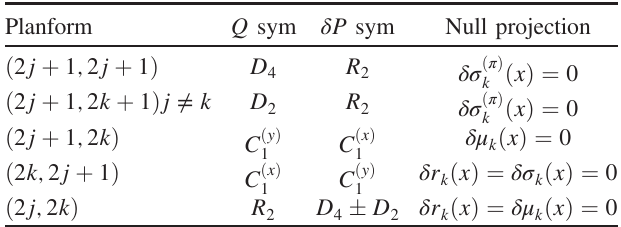
TABLE I. Column 1: Planform patterns for the modes ψ k in Fig. 6. Column 2: Their symmetry group — dihedral group D n , reflection group C n , and rotation group R n . Column 3: Symmetry group of the companion precursor P field. Column 4: Associated fluctuation fields, which vanish identically.